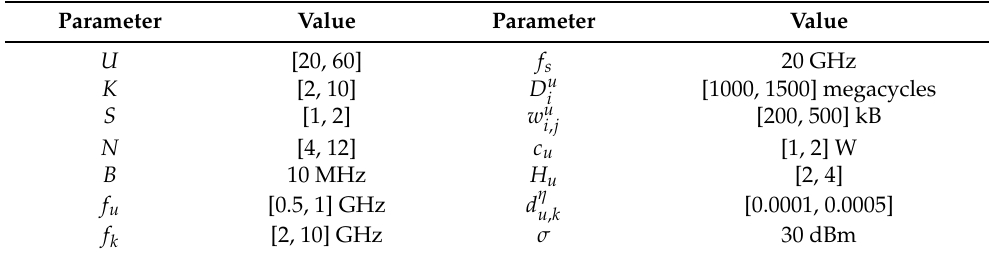
Table 2. Parameters and